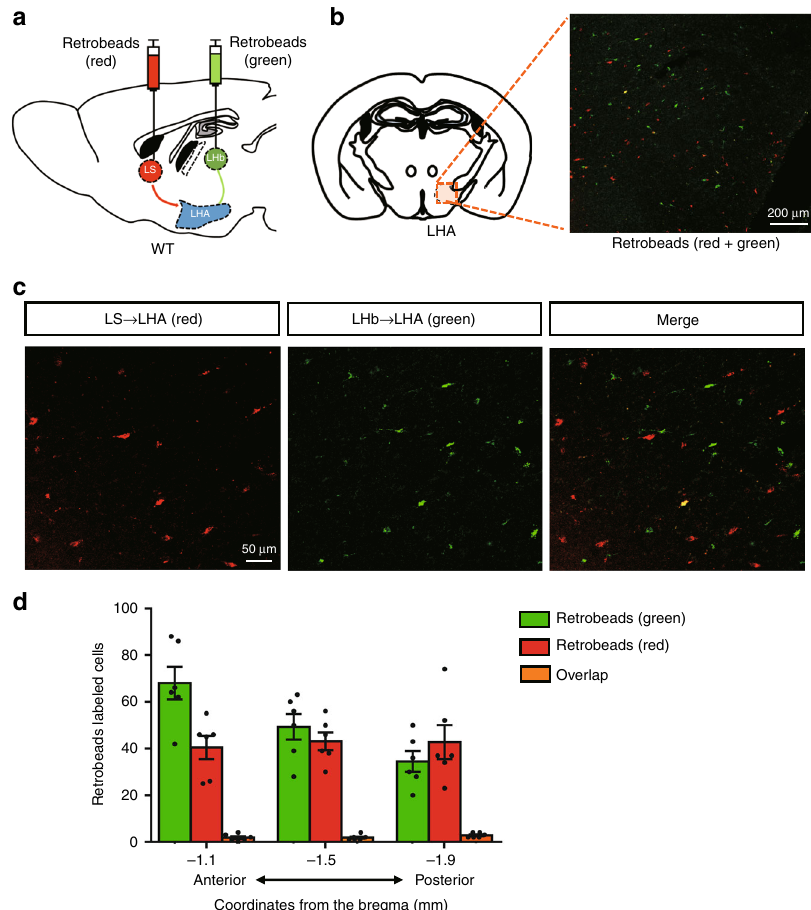
Fig. 7 Different neuronal populations in the LHA project to the LS and LHb. a Schematic image of the retrobead injections into the LS (red) and LHb (green) in WT mice. b Retrograde transport of redbeads (from the LS) and green beads (from the LHb) in the LHA. c Representative enlarged confocal image of redbead-labeled cells (from the LS) and greenbead-labeled cells (from the LHb) in the LHA. d Quanti fi cation of red and green retrobead-labeled cells in the LHA along the anterior – posterior axis. Retrobead-positive cells were counted in three sections at different AP locations from n = 2 mice. Data are given as means ±